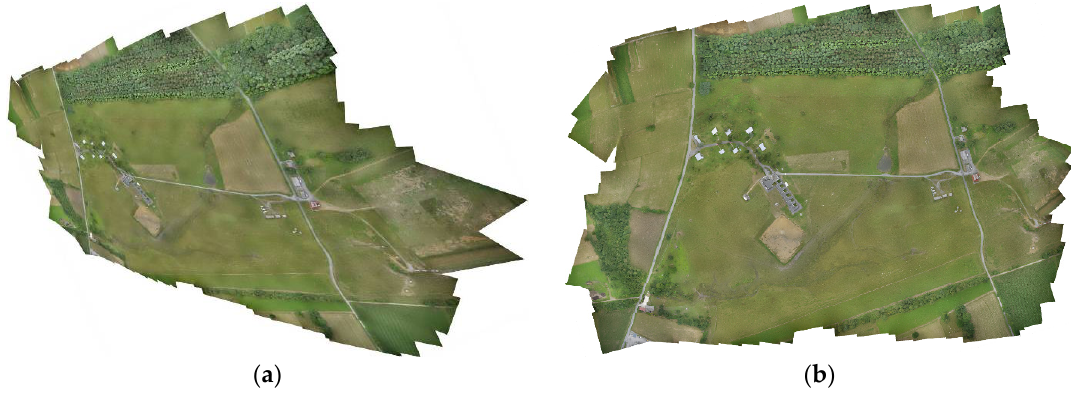
Figure 10. Mosaicking result of Dataset 4 obtained using reference image shown in Figure 9b: ( a ) mosaicking result using Capel’s method; and ( b ) mosaicking result using the proposed algorithm. Table 3. Mosaicking errors for Dataset 4 obtained using different methods and reference images.